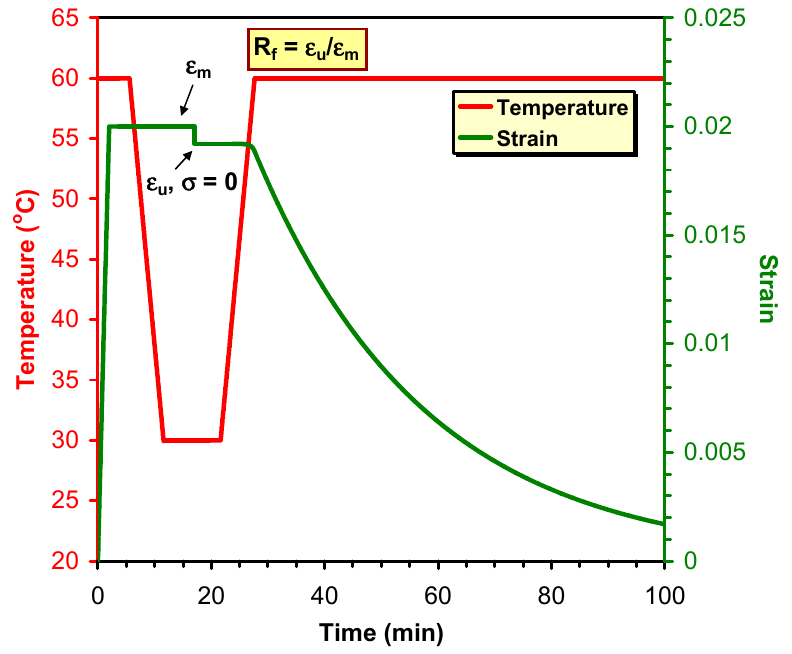
Figure 10. A simulation for a virtual shape memory programming based on the SLS model. Simulation parameters are: E eq = 100 MPa, E 1 = 2900 MPa, τ = 1 min, heating and cooling rate = 5 ◦ C/min, AF c / k b = − 40,000 K where A is a material constant, F c and k b are the configurational energy and the Boltzmann’s constant, respectively.